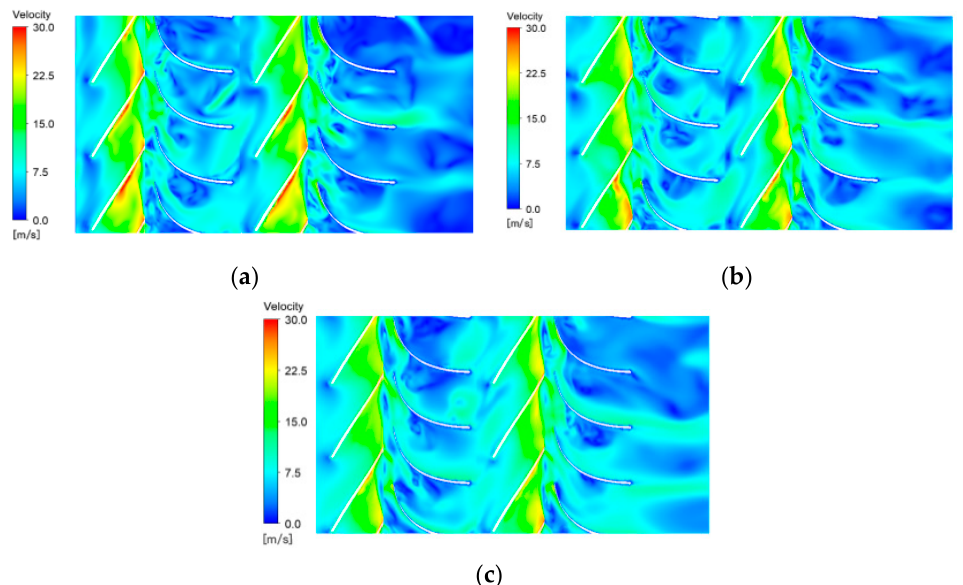
Figure 16. Velocity distribution on first-stage impeller-guide vane B2B view: ( a ) 0.68 Q d ; ( b ) 1.0 Q d ; ( c ) 1.33 Q d .